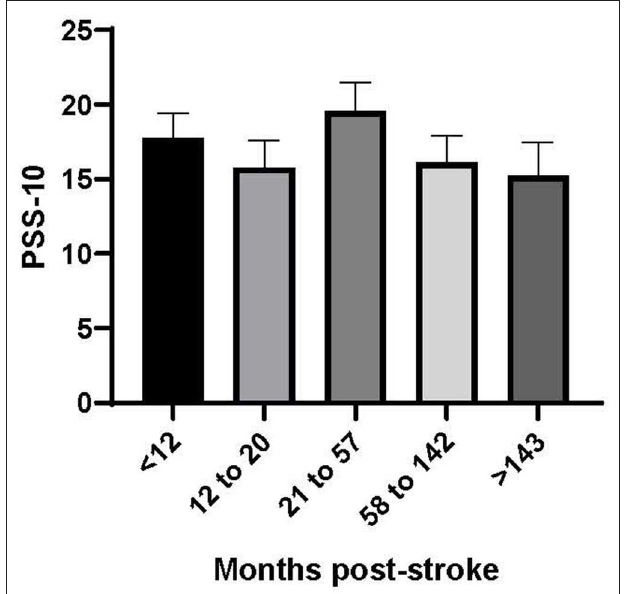
FIGURE 1 | Perceived stress score (PSS-10) by time post-stroke (months). Time post-stroke is reported in quintiles ( n = 14 per